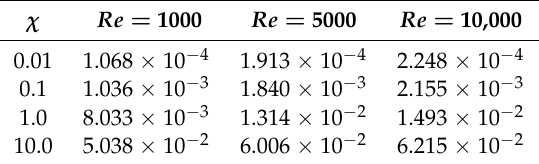
for the lid-driven cavity L 2 ([ 0,1 ] ; L 2 ( Ω ))